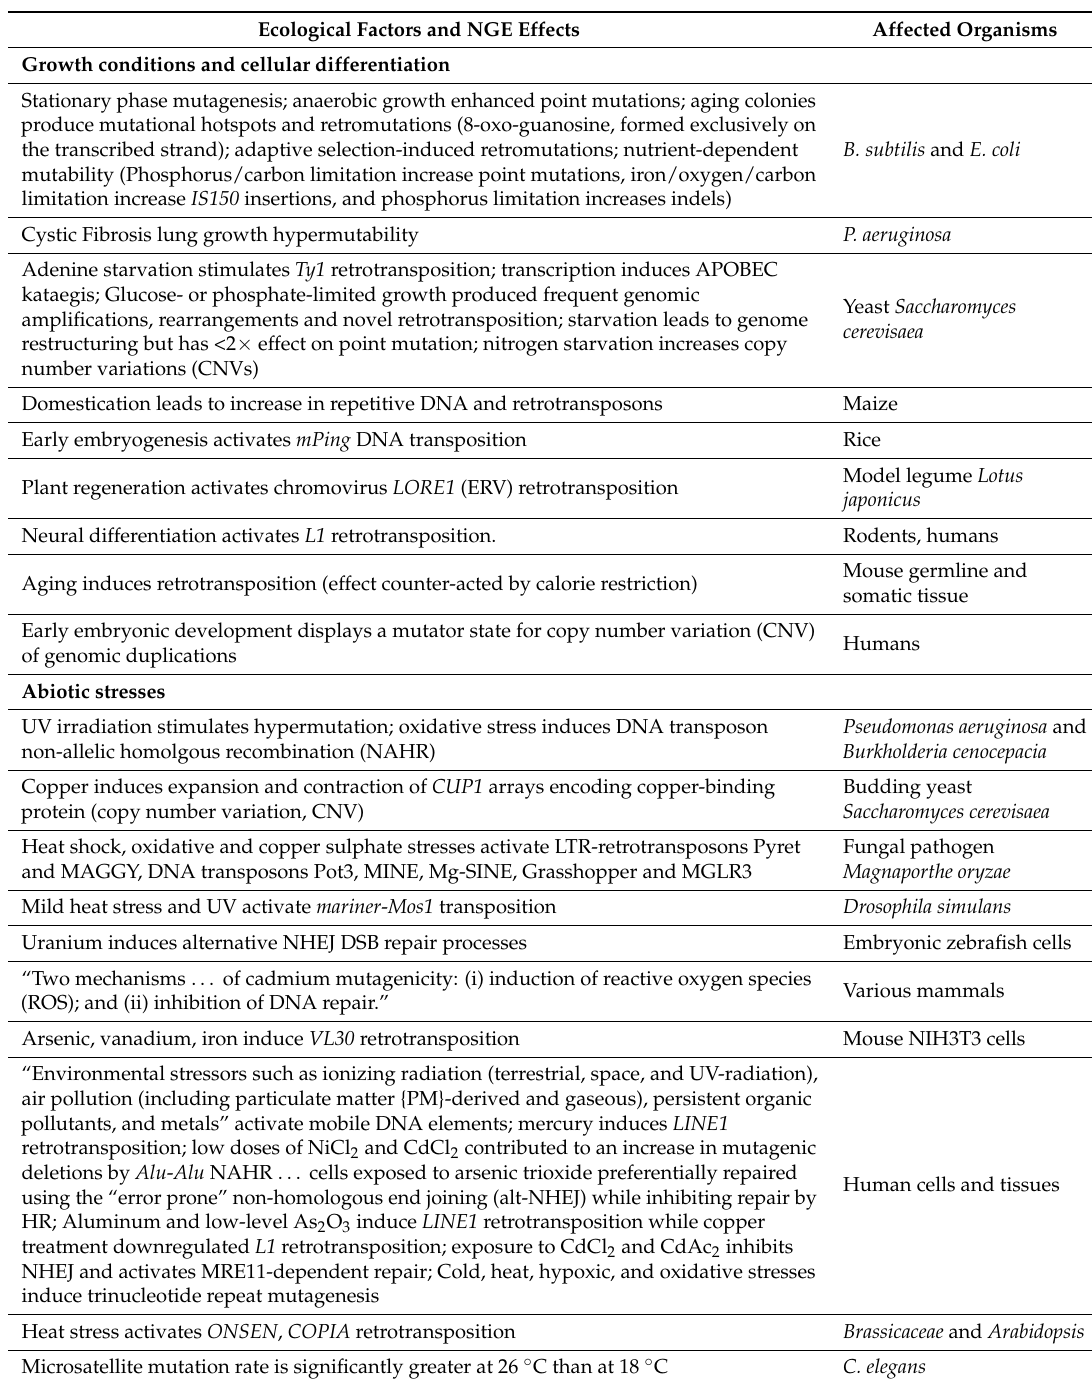
Table 16. Ecological Factors that Induce Mutagenic DNA Repair or Modulate Natural Genetic Engineering (NGE)